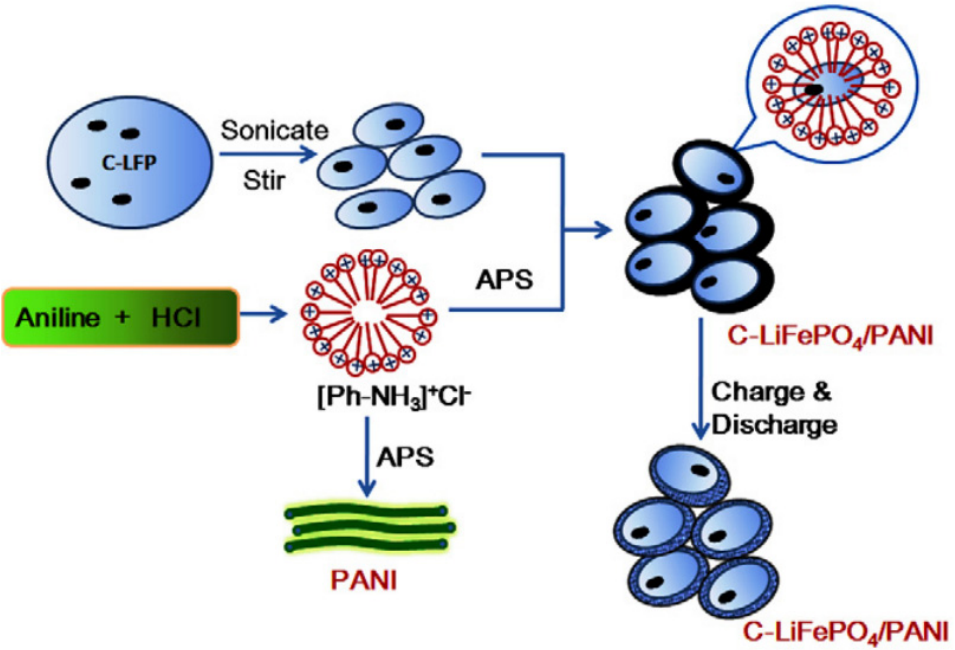
Figure 2. The formation mechanism for PANI nanofiber and PANI-coated C-LFP composite via a self-assembly process [52]. Reprint with permission from [52]; Copyright 2011,